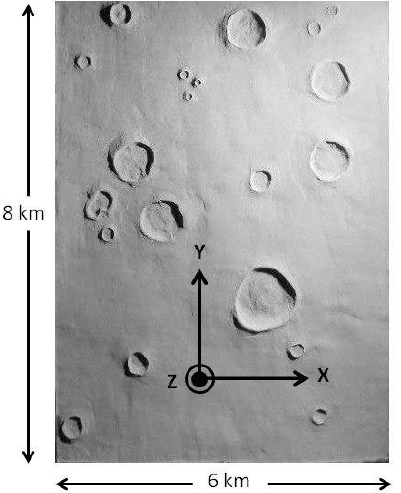
Figure 3. Simulated lunar landing terrain and example of a possible reference frame.